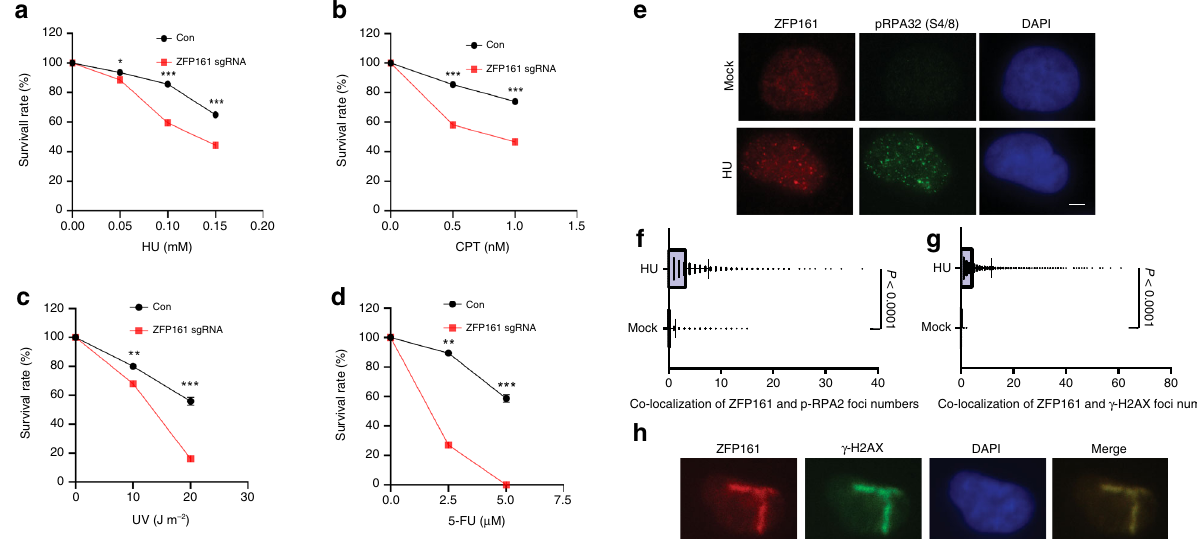
Fig. 1 ZFP161 is involved in the replication stress response. a – d HCT116 cells were plated and treated with Hydroxyurea (HU, mM) ( a ), Camptothecin (CPT, nM) ( b ), Ultraviolet (UV, J m − 2 ) ( c ), and Fluorouracil (5-FU, µ M) ( d ). After 14 days, colony numbers were counted. The graphs represent mean ± S.D., two-tailed, paired t -test. e The co-localization of phospho-RPA32 (S4/S8) and ZFP161 was determined by immuno fl uorescence. f , g Quanti fi cation for co- localization of ZFP161 per cell with phospho-RPA32 (S4/S8) ( f ), and γ H2AX ( g ). The graphs represent mean ± S.D., two-tailed, unpaired t -test. h Cells were stained with ZFP161 and γ H2AX 2 h after microirradiation. Scale bars, 10 µ m. Source data are provided as a Source Data fi